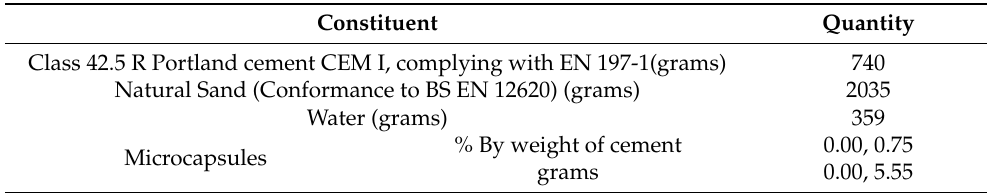
Table 2. Mortar mix